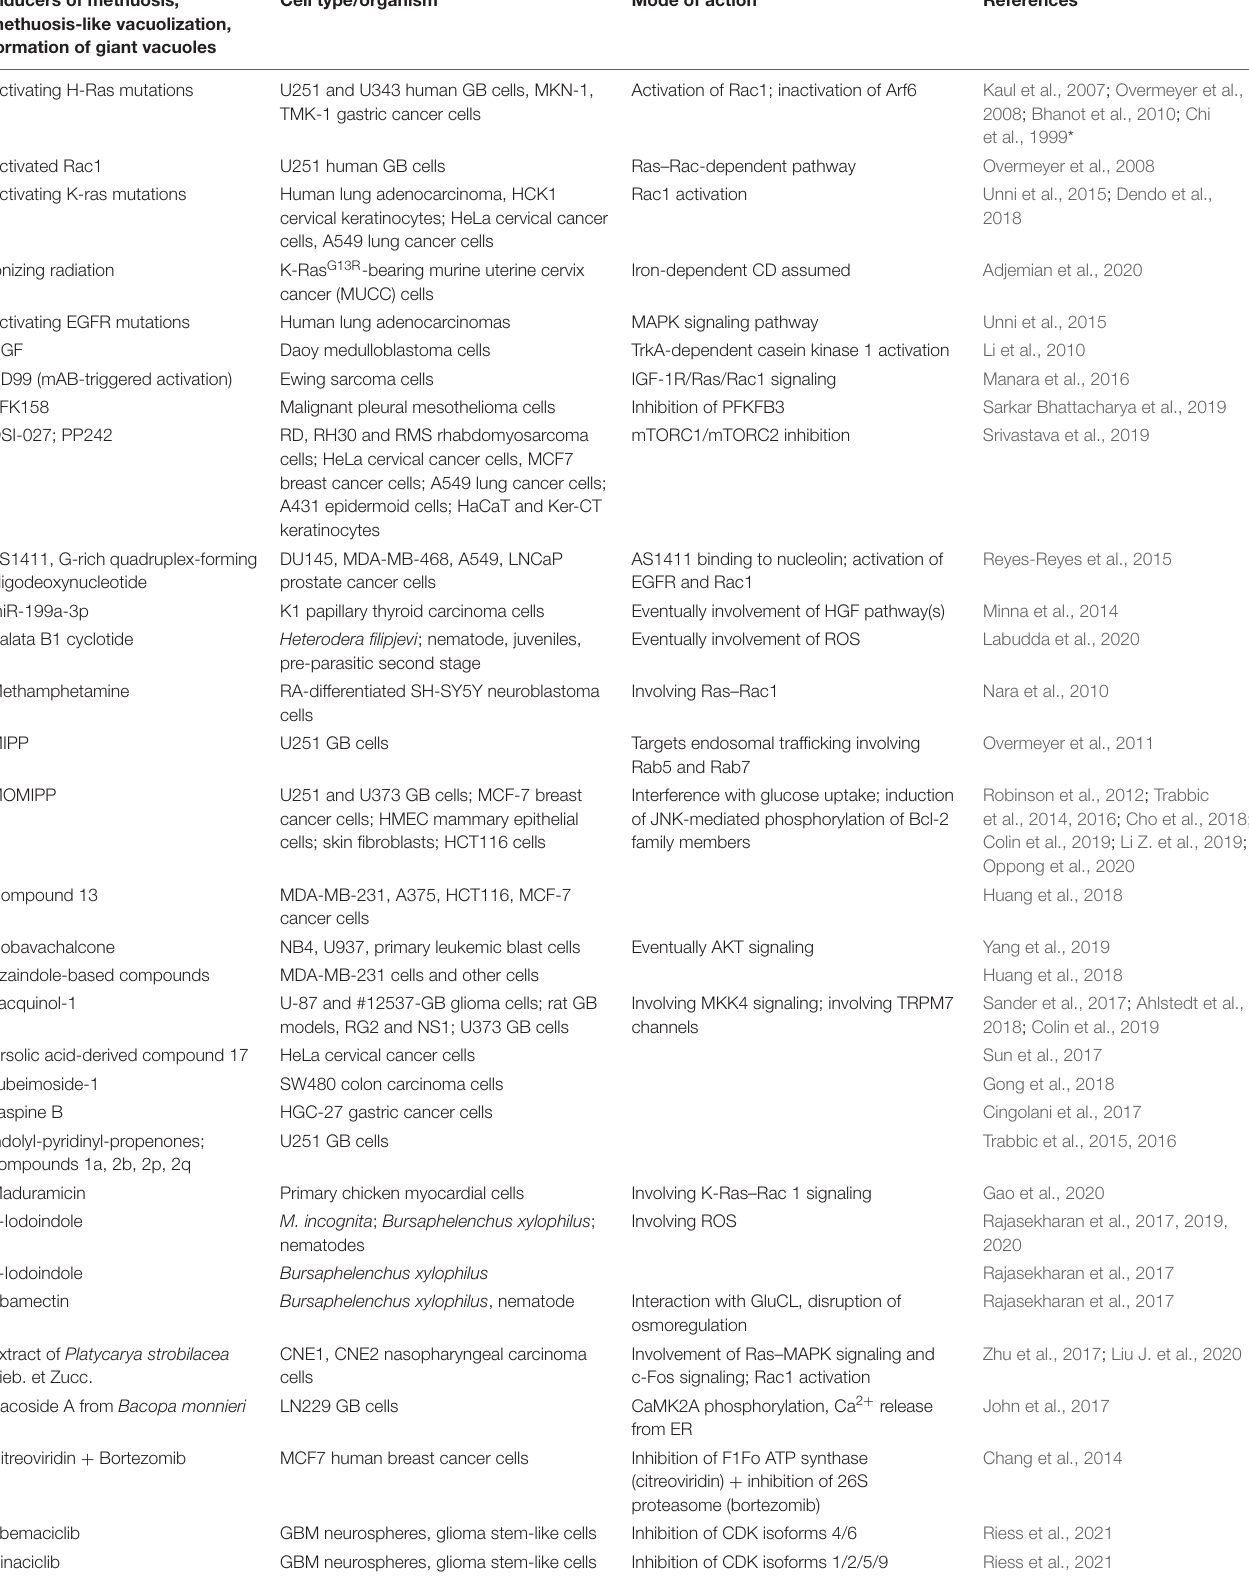
TABLE 2 | Inducers of methuosis, cell death associated with aberrant vacuolization, and formation of strongly enlarged vacuoles. Inducers of methuosis, methuosis-like